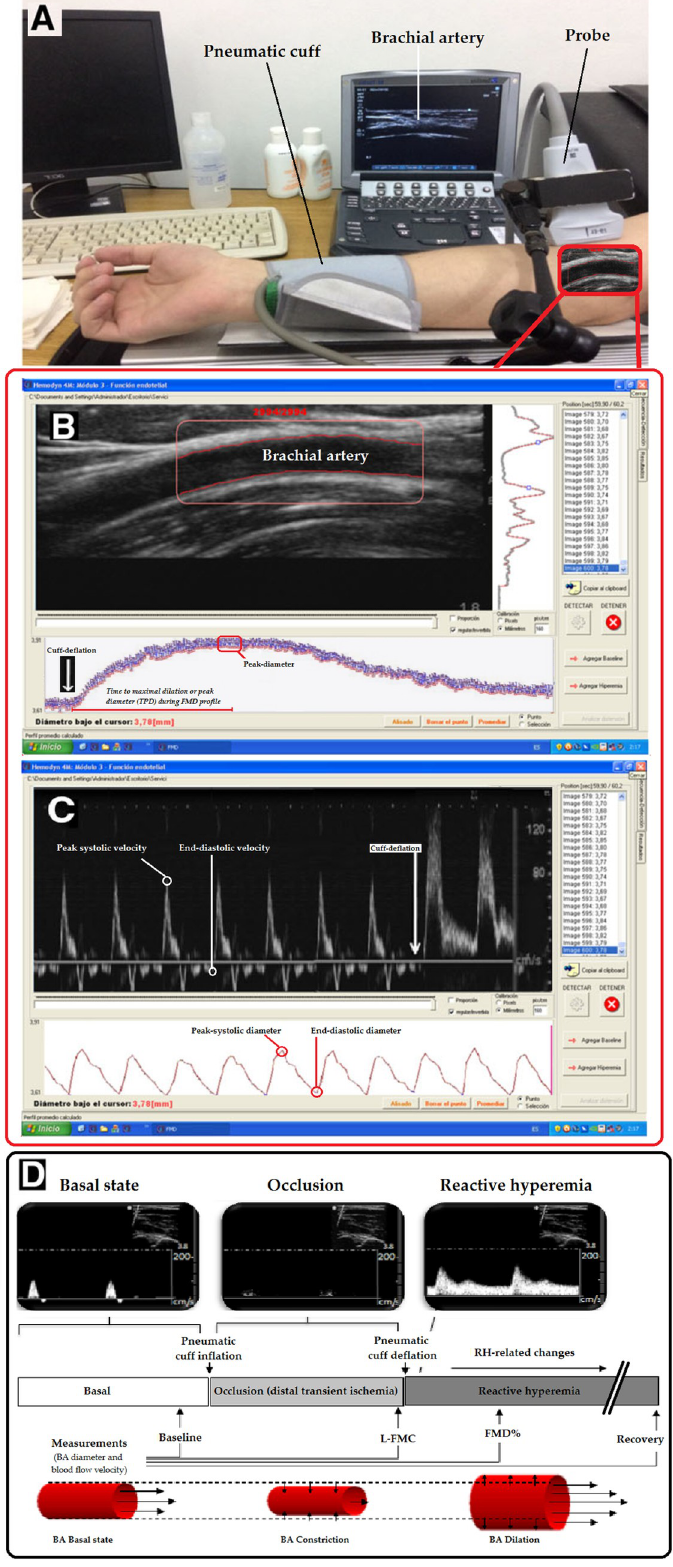
Fig 1. Vascular reactivity assessment. A: Instrumentation for vascular reactivity (VR) evaluation. B: Brachial artery (BA) characteristic image (top) with software tracking vessel wall over time (edge detection analysis) in the region of interest (ROI), so as to reconstruct beat-to-beat BA diameter temporal profile (bottom), before and after cuff-deflation PLOS ONE | https://doi.org/10.1371/journal.pone.0254869 July 19,